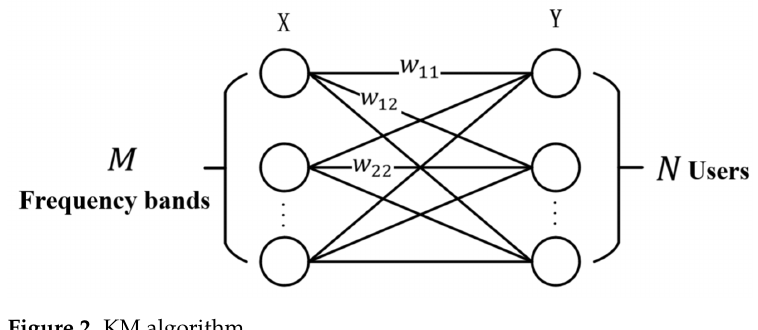
Figure 2. KM algorithm.